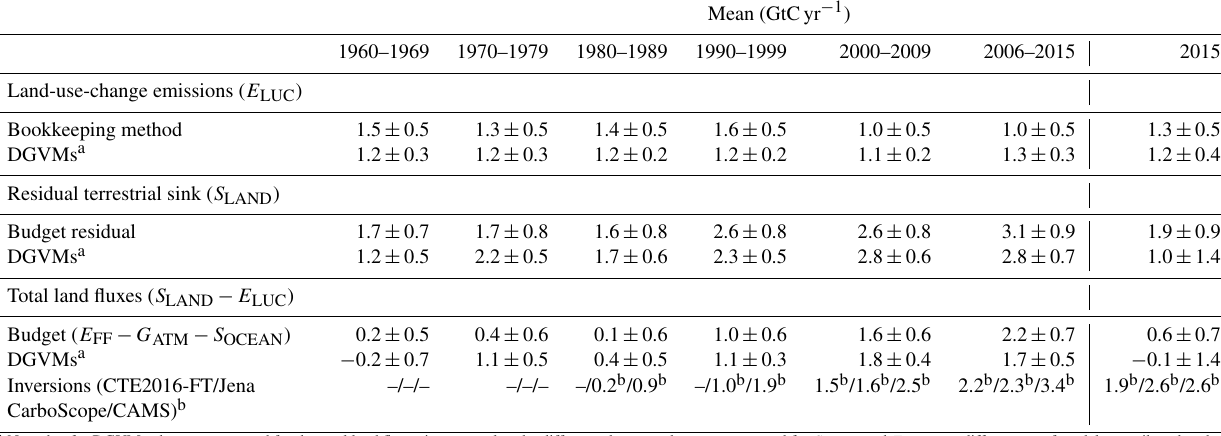
Table 7. Comparison of results from the bookkeeping method and budget residuals with results from the DGVMs and inverse estimates for are in GtCyr − 1 . The DGVM uncertainties represent ± 1 σ of the decadal or annual (for 2015 only) estimates from the individual models; for the inverse models all three results are given where